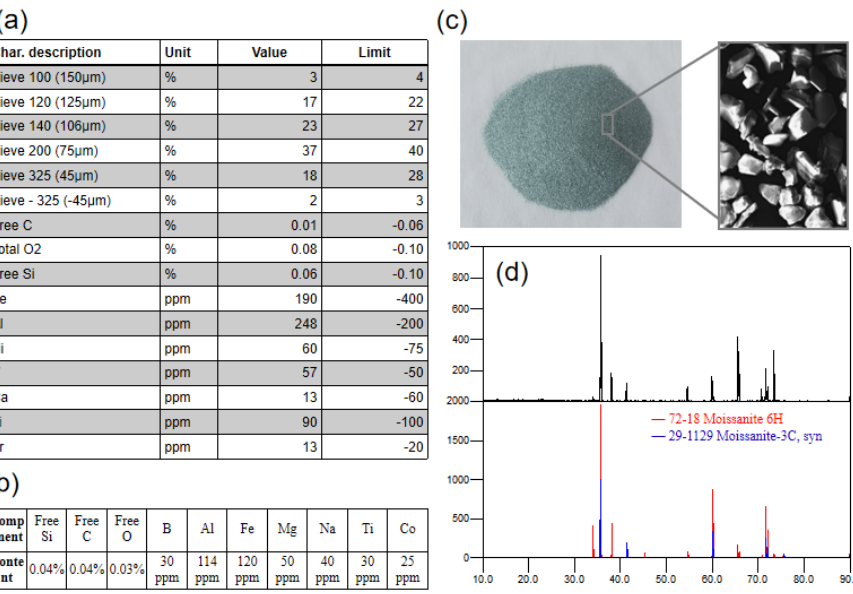
Figure 1. Schematic diagram of the furnace.